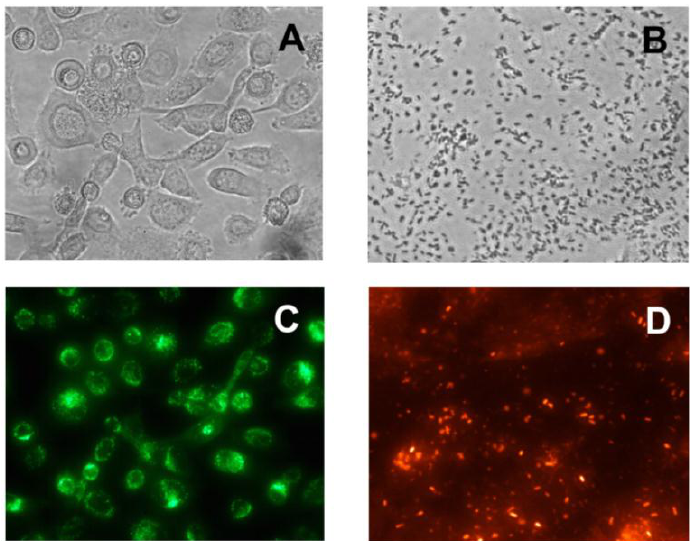
Figure 2. Micrographs of epithelium cells ( A , unstained; C , stained with PKH67) and Pseudomonas aeruginosa ( B , unstained; D , stained with PKH26). Fluorescent cells were examined on a Nikon Eclipse microscope equipped with a filter 31001 FITC C87701 for